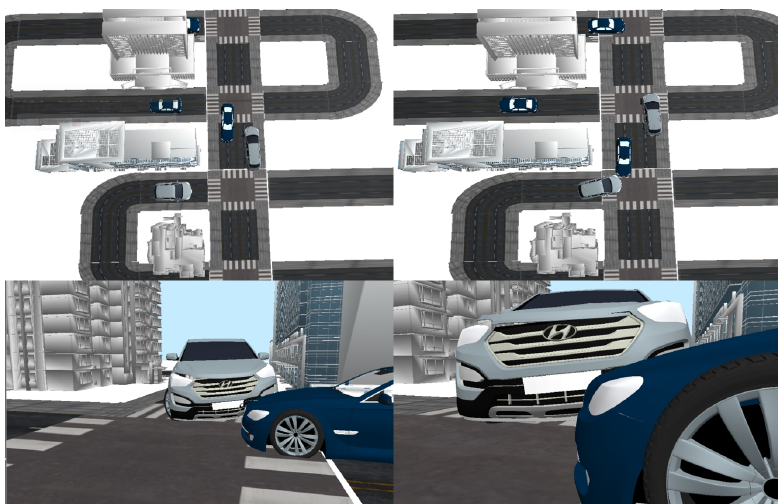
Figure 13. Traffic scene created with background and multiple vehicle models.